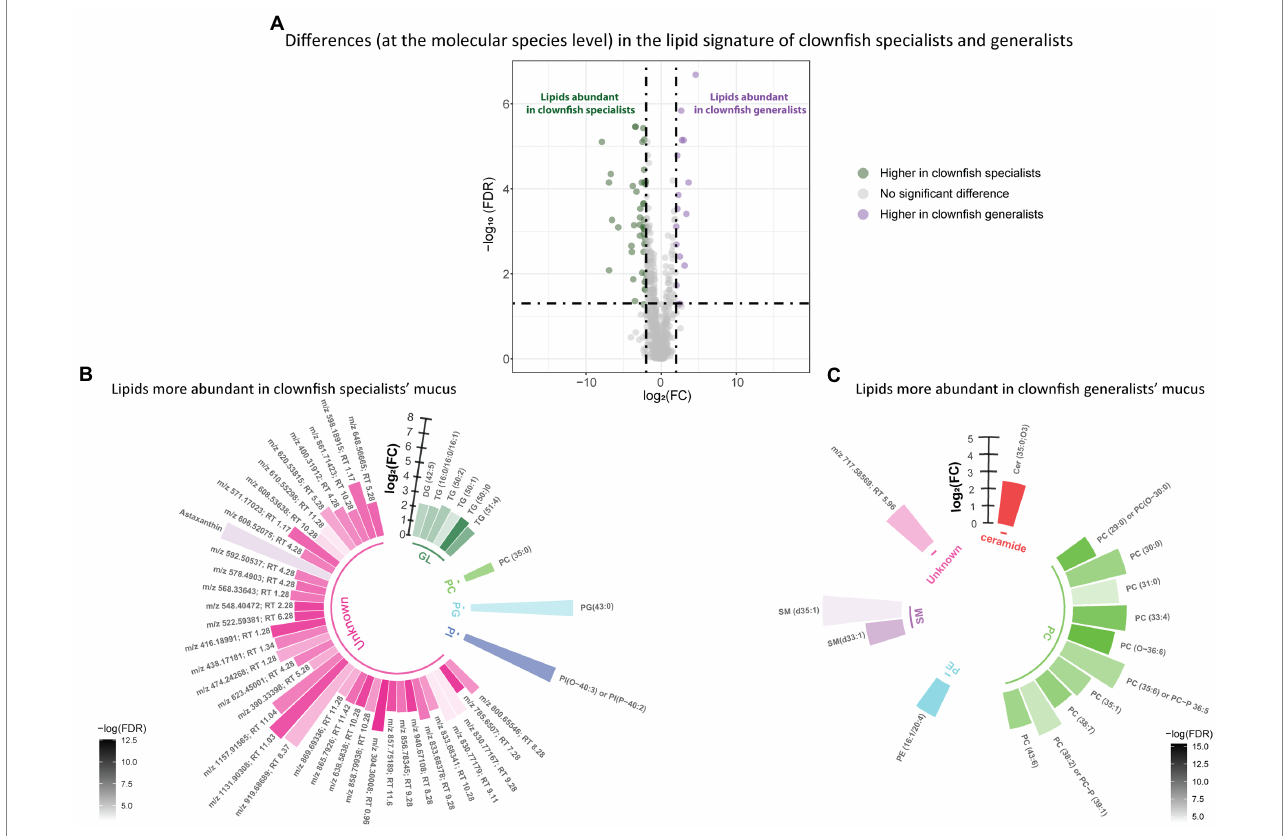
FIGURE 3 (A) Volcano plot of the global lipidome detected in the clownfish generalist and specialist individuals. The log 2 (Fold change) limit at − 2 and 2 highlights the lipid features higher in clownfish specialists (dark green) and the lipids higher in clownfish generalists (purple). These lipids are subsequently represented in circular bar plots (B) and (C) to highlight the identified lipids and lipid classes differing between these two clownfish groups. Each colour represents a lipid class and the different shades of one colour reflect the -log(FDR) of each lipid, calculated performing a t